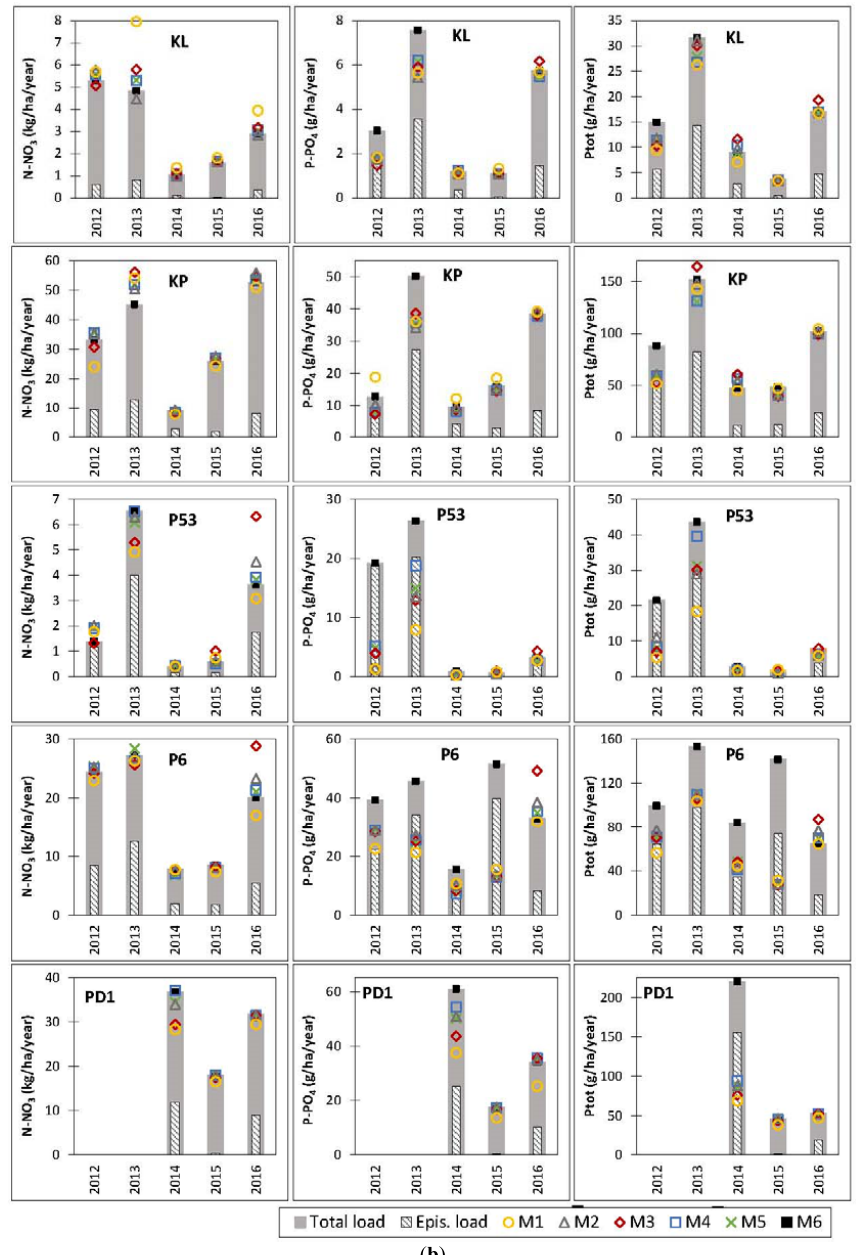
Figure 6. ( a ) Annual nutrient loads calculated by M1 to M6 and the proportion of runoff events in the total load for all substances at sites KL, KP, P53, P6, and PD1 and for all monitored periods. ( b ) Annual nutrient loads calculated by M1 to M6 and the proportion of runoff events in the total load for all substances at sites PD2, Š2, V1, VP1, and VP2 and for all monitored periods.